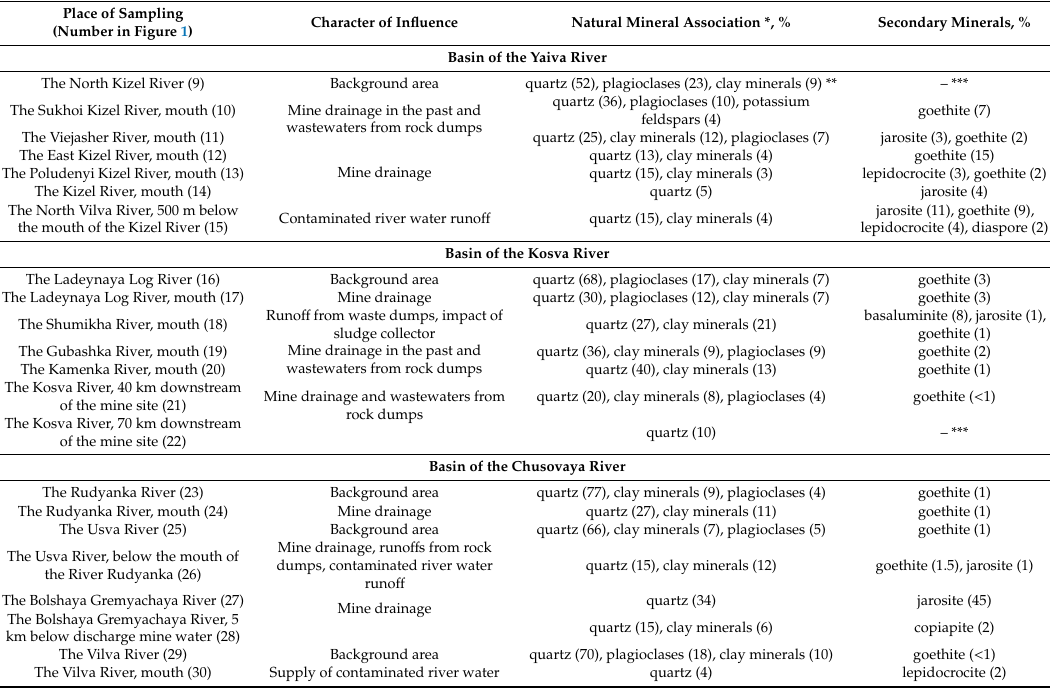
Table 2. Mineral composition of silty-clayey sediments of the